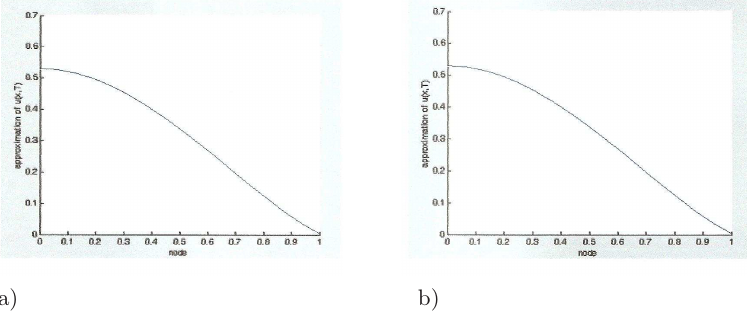
Figure 3. Profile of the approximation of u ( x,T ) where, T is the quenching time: a) Explicit scheme, b) Implicit